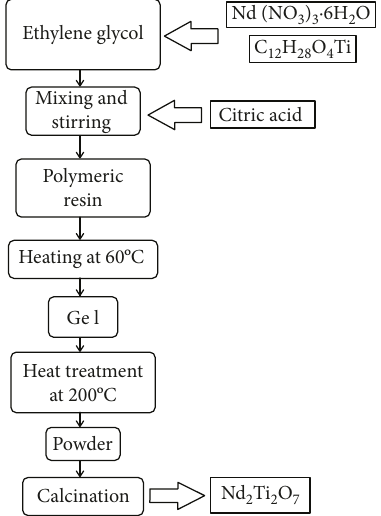
Figure 1: Scheme of the synthesis of Nd